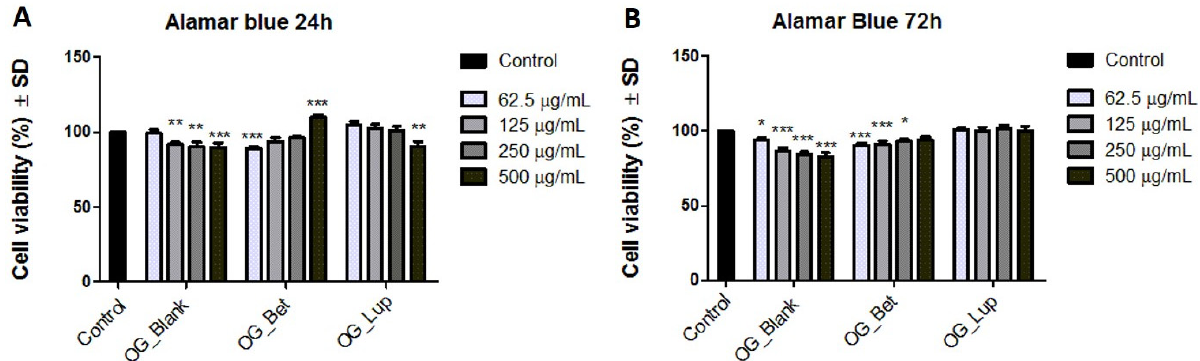
Figure 5. Cell viability assessment of the three oleogels (Blank OG, Bet OG, and Lup OG) in HaCaT cells at 24 h ( A ) and at 72 h ( B ) post-stimulation by means of Alamar blue assay. The results are expressed as a cell viability percentage (%) normalized to control cells stimulated with cell medium. The data represent the mean values ± SD of three independent experiments. A one-way ANOVA analysis was applied to determine the statistical differences compared with control-treated cells followed (* p < 0.1; ** p < 0.01; *** p < 0.001).